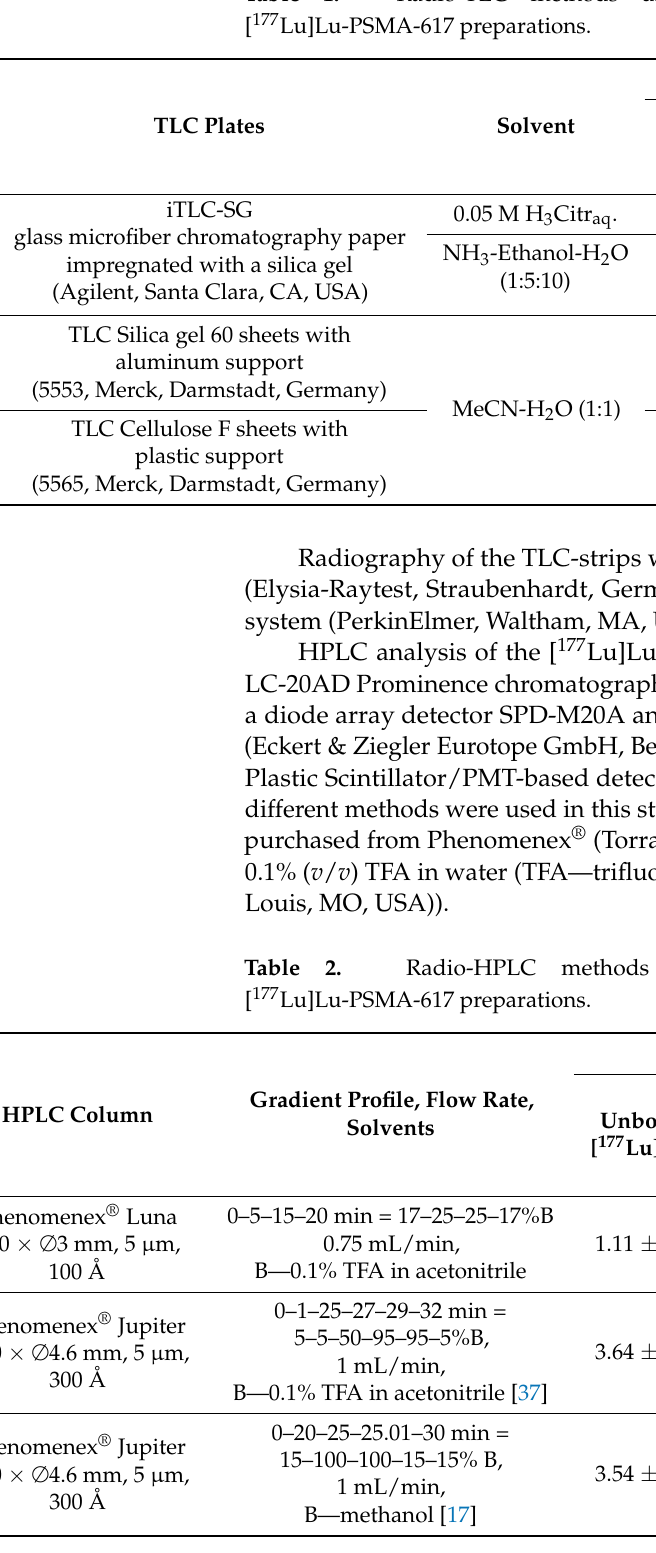
Radio-TLC methods used to analyze the radiochemical conversion of